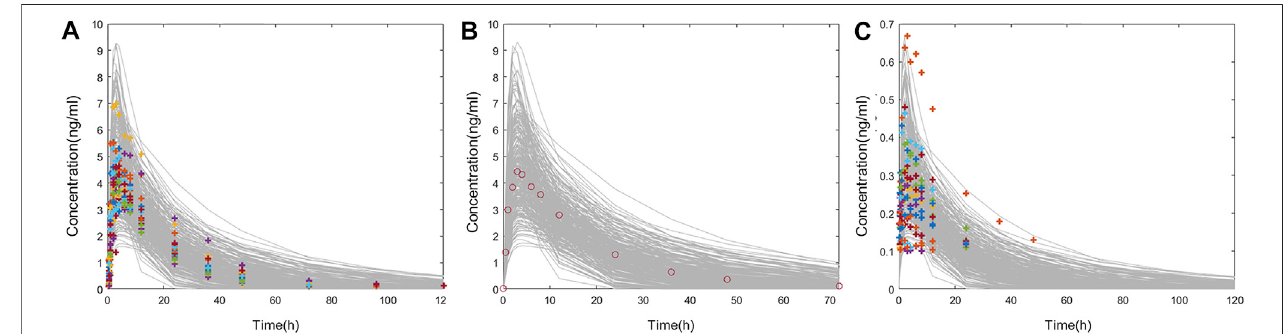
FIGURE5|(A) ComparisonofindividualPKdatafollowingoraladministrationof1 mgvareniclineinAmericans(coloredcross)andtheconcentration – timecurvein 300 American virtual subjects (gray line). (B) Comparison of mean PK data following oral administration of 1 mg varenicline in Chinese (red circle) and the